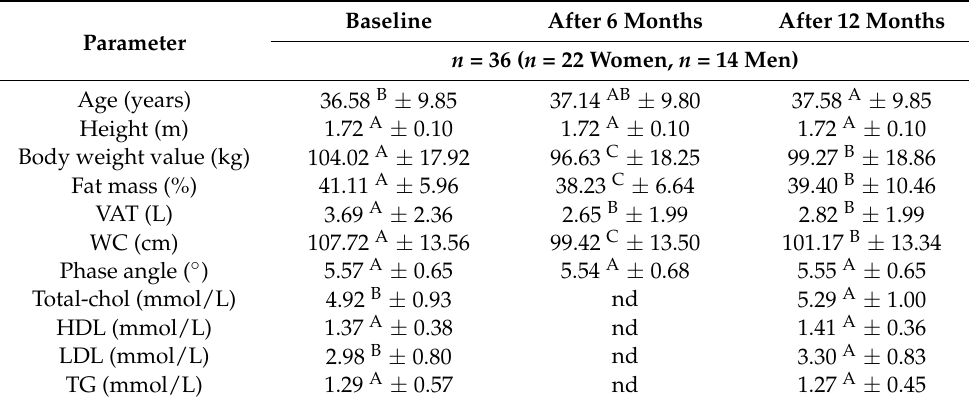
Table 1. Characteristics of the studied group during the weight loss